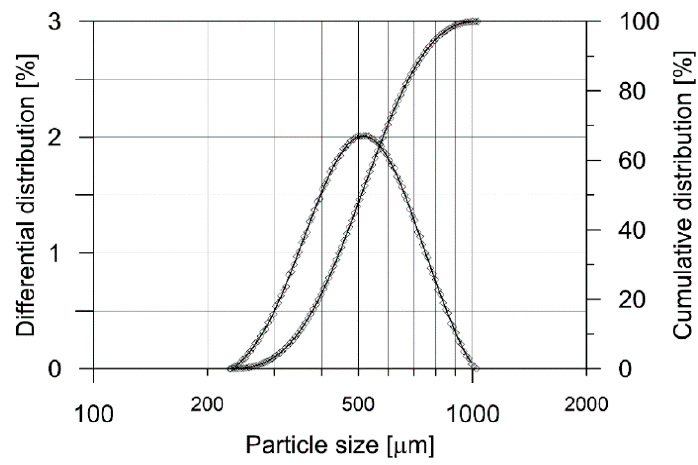
Figure 2. Granulometric distribution curves of the sieved sample of silica gel.